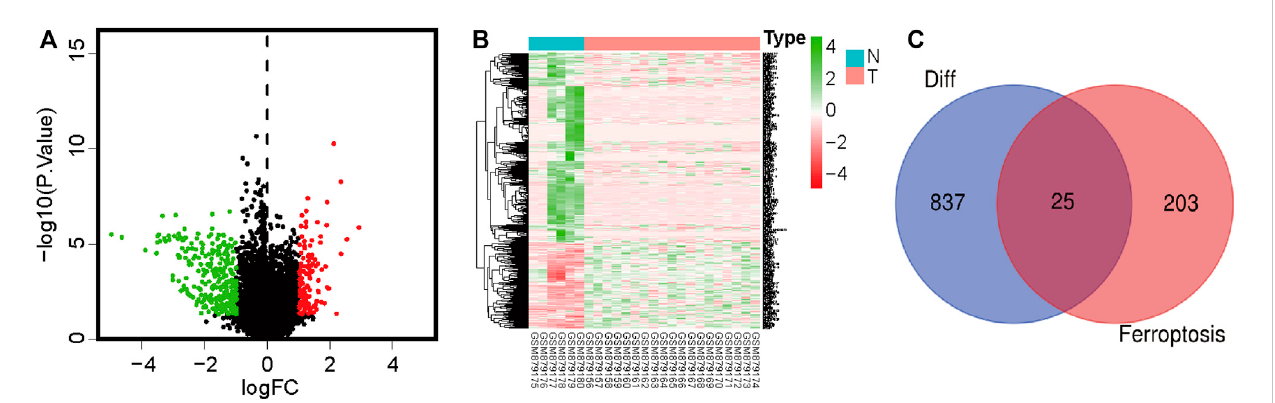
FIGURE 1 Volcano plot showing differences in gene expression in osteosarcoma and paracancerous tissues. Red color indicates signi fi cantly upregulated genes, green color indicates signi fi cantly downregulated genes, and black color indicates no signi fi cant difference in gene expression. (A) Volcano plot showing differentially expressedgenes. (B) Heatmap of differentially expressed genes. (C) Venn diagram showing intersections betweendifferentially expressed genes and ferroptosis-related genes.